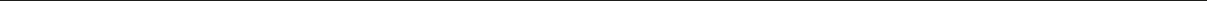
Fig. 3 Mitotic gene downregulation and senescence gene signature in elderly mitotic fi broblasts. a Experimental layout. Fibroblast cultures from different age donors were treated with kinesin-5 inhibitor (STLC) to enrich for mitotic index (MI). Mitotic (detached) cells were collected and inspected for MI. Protein extracts and total RNA were prepared for gene expression analyses. b Representative images of neonatal (HDF N) and elderly (HDF 87 y) mitotic cell shake-offs. Insets are ×2 magni fi cations. Scale bar, 50 µ m. c MI quanti fi cation of neonatal and octogenarian mitotic cell shake-offs. d Number of altered genes in HDF 87 y RNA-seq comparing to HDF N (Supplementary Data 1). e RNA-seq multidimensional scaling (MDS) plot. Axes in MDS plot represent leading log-fold changes (logFCs) calculated by the root-mean-square of the largest absolute logFCs between each pair of libraries. f Top ten altered GO terms organized by p -values using the DAVID Functional Annotation tool. g Heatmap of genes within the “ mitosis ” GO term differentially expressed between HDF N and HDF 87 y (Supplementary Data 2). h Heatmap of SASP and senescence-associated ( CDKN1A , LMNB1 ) genes differentially expressed between HDF N and HDF 87 y (Supplementary Data 4); 2logFCs in red indicate genes behaving differently from expected 36, 37 . i Heatmap of senescence core signature genes differentially expressed between HDF N and HDF 87 y (Supplementary Data 5); 2logFCs in red indicate genes behaving differently from expected 37 . In all heatmaps, 2logFC cutoff value < − 0.5 and >0.5, p -value < 0.05; genes represented in columns and technical replicates represented in rows; Z -score column color intensities representing higher (red) to lower (blue) expression. j Transcript levels of senescence genes in total RNA from mitotic elderly samples normalized to TBP transcript levels and compared with neonatal. NS, p > 0.05, * p ≤ 0.05, and ** p ≤ 0.01 by